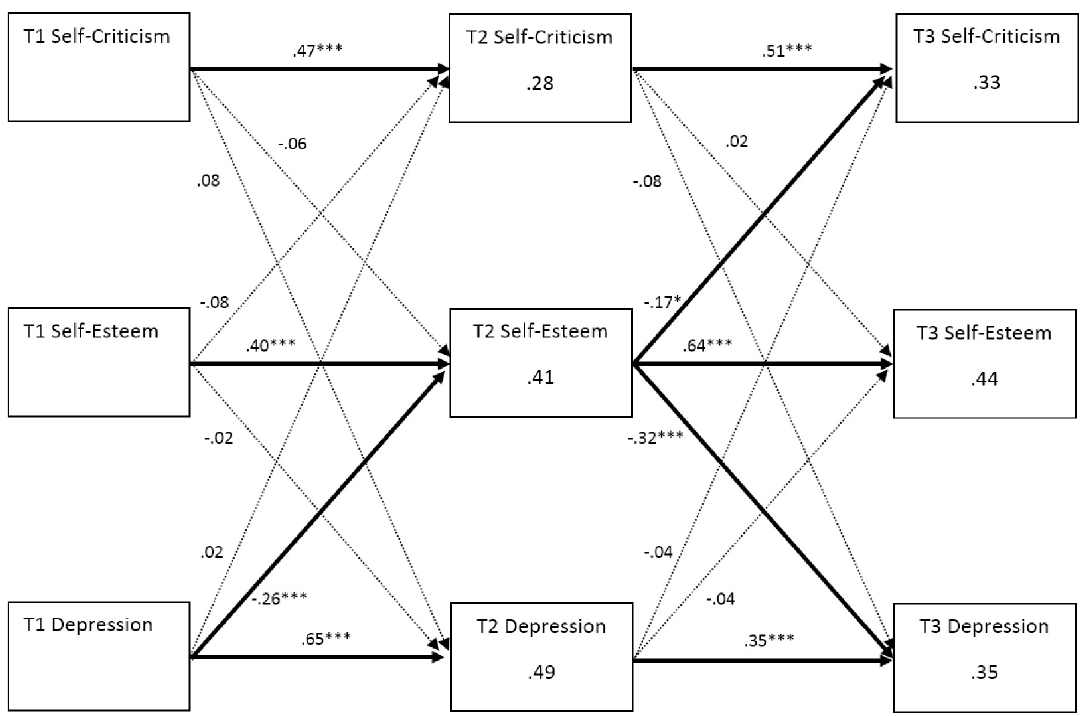
Fig 2. Cross-lagged model. Standardised estimates are displayed. Dotted lines indicate non-significant pathways. Covariances and error terms have been excluded from figure for clarity. T1 = Time 1; T2 = Time 2; T3 = Time 3. � p < .05; ��� p < .001.